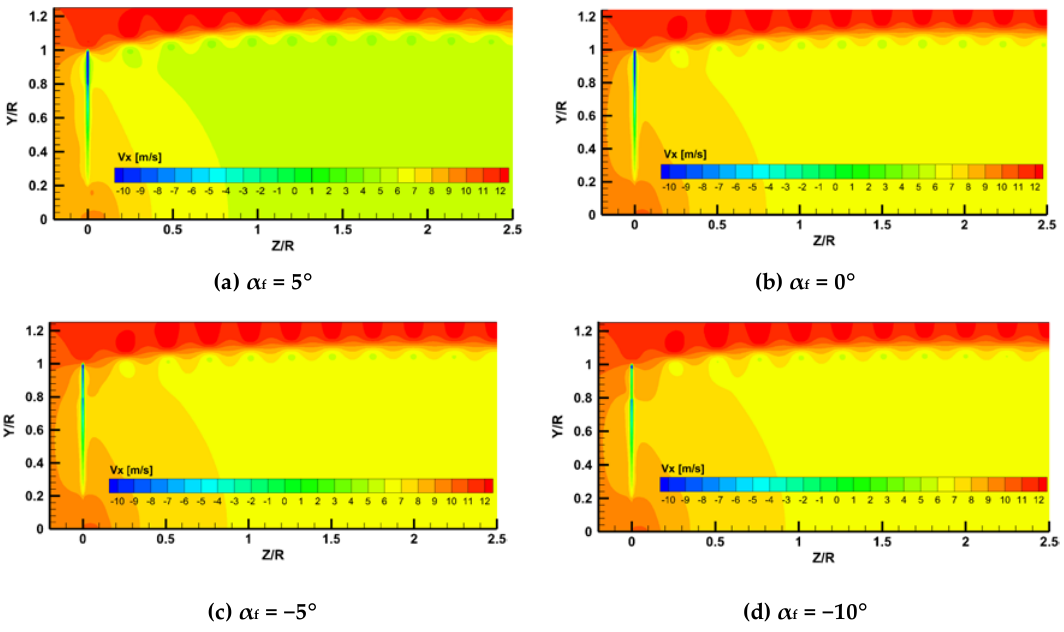
Figure 9. Axial velocity distribution on the plane with a 0° wake angle for U = 11.4 m/s. (Position: Axial direction from − 0.2 R to 3 R , radial direction from 0 to 1.25 R ). ( a ) α f = 5°, ( b) α f = 0°, ( c ) α f = −5 °, ( d ) α f = −10 °.